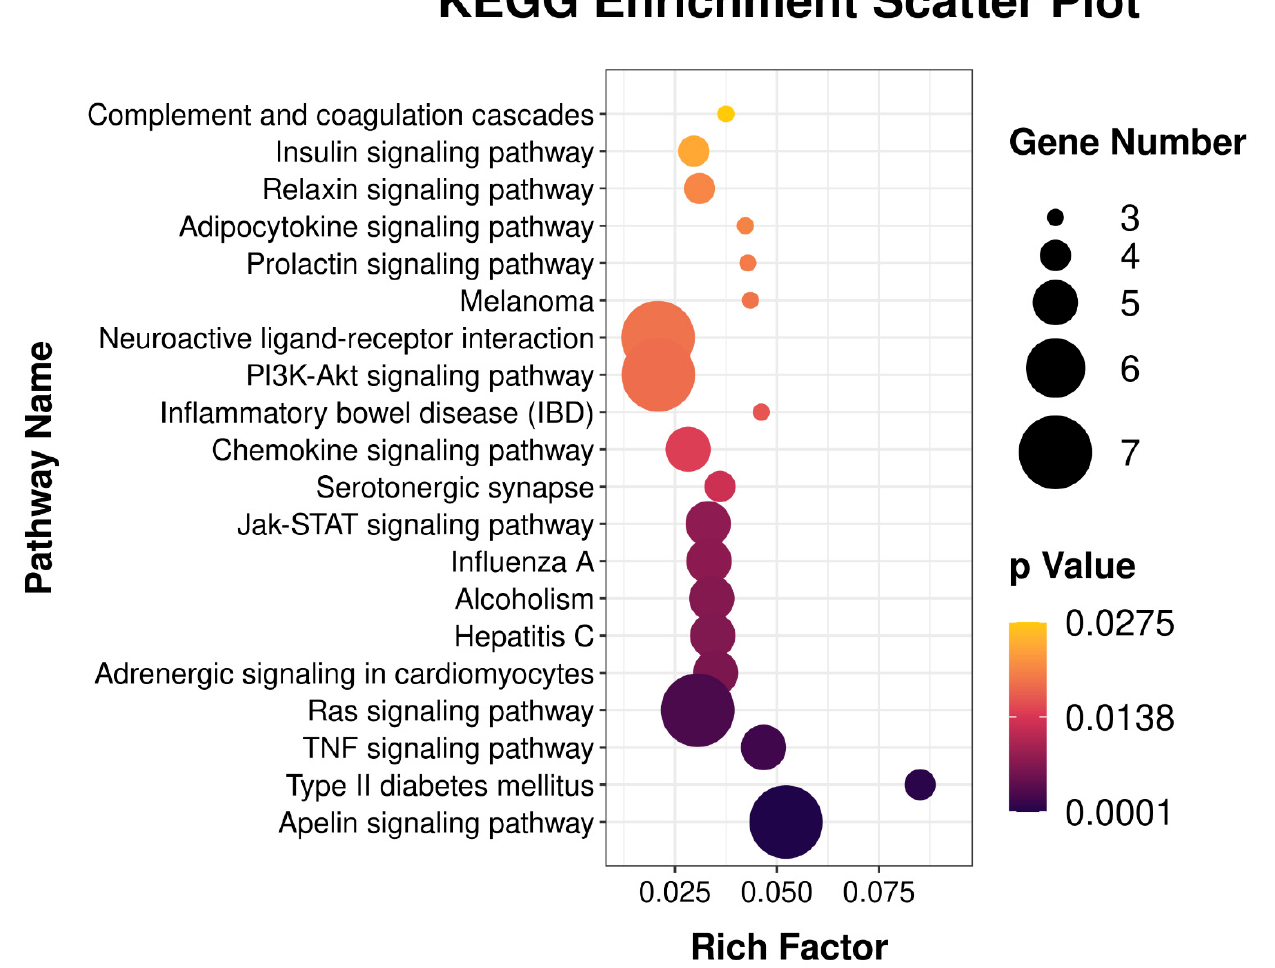
Figure 6. The column diagrams for Kyoto Encyclopedia of Genes and Genomes (KEGG) analysis of DEGs. The x-axis represents the numbers of DEGs. The y-axis represents the functions of pathways. The color depth represents p -value.